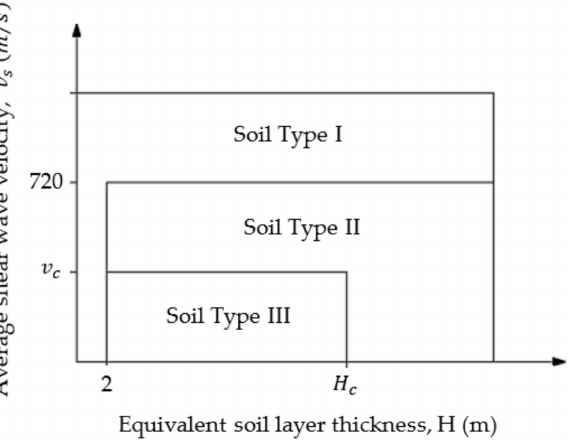
Figure 4. Soil microzoning using thickness, H s , and average shear wave velocity, v s , adapted with permission from Ulises Mena, Comisi ó n Federal de Electricidad Manual de Diseño de Obras Civiles; published by Comision Federal de Electricidad (CFE), 2015